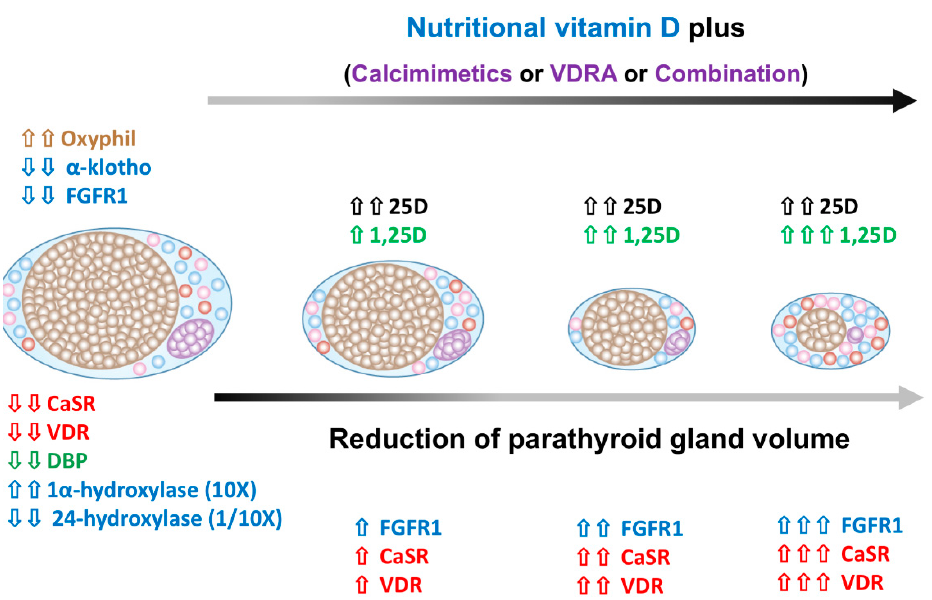
Figure 2. Parathyroid gland regression after parathyroid hormone (PTH) lowering therapy. Calcitriol and calcimimetics can effectively reduce PTG volume in SHPT and concurrently increase VDR and CaSR expression to improve the efficient SHPT treatment. NVD supplement meets the demand of parathyroid 25D requirement and lower PTH by dramatically increasing intra-gland 1,25D